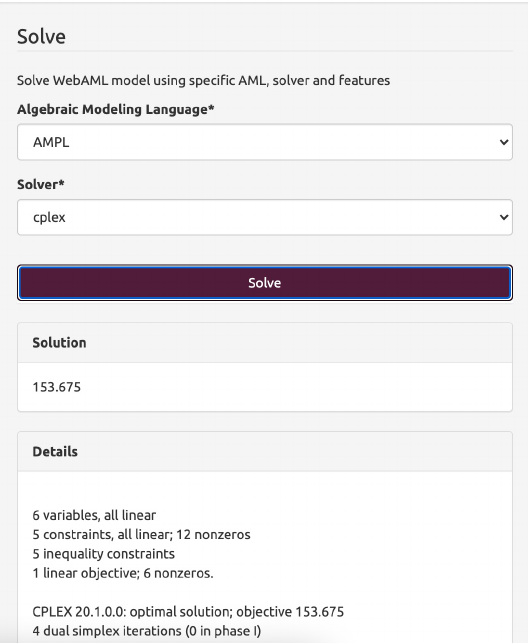
Figure 4. Screenshot of the user interface for the WebAML Optimization System. Obtained solution of the transportation